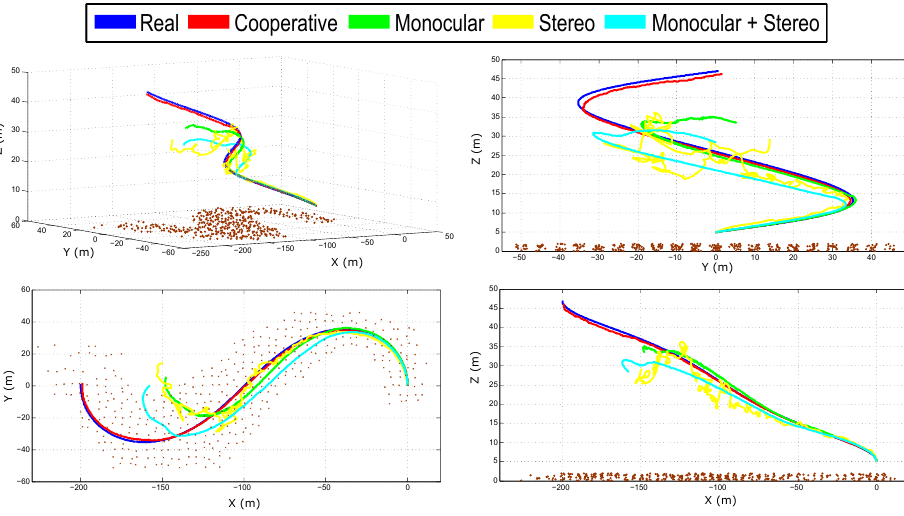
Figure 7. Estimated trajectory of Quad 1 obtained with all the